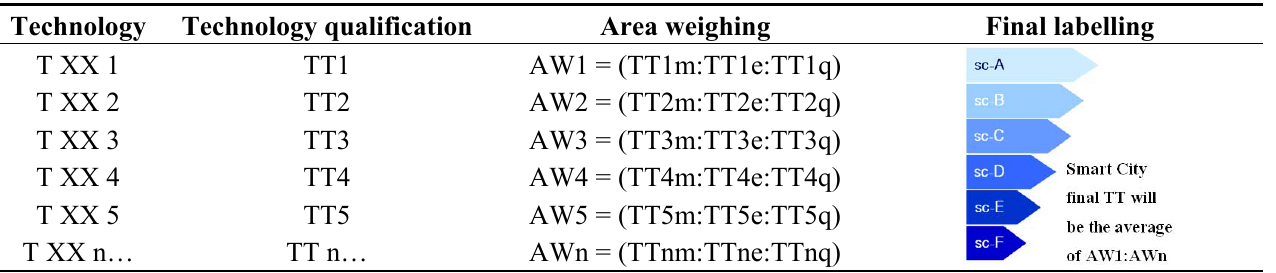
Table 3. Smart City final qualification Matrix